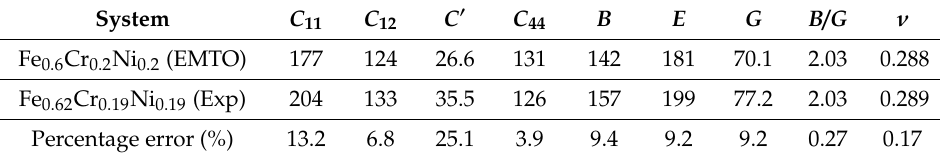
Table 1. Theoretical (exact muffin-tin orbitals, EMTO) and experimental (Exp) [8] elastic constants (in GPa) for paramagnetic fcc Fe–Cr–Ni alloys. B/G and ν are dimensionless. In the last row, we present the percentage error between the experimental and theoretical elastic constants.